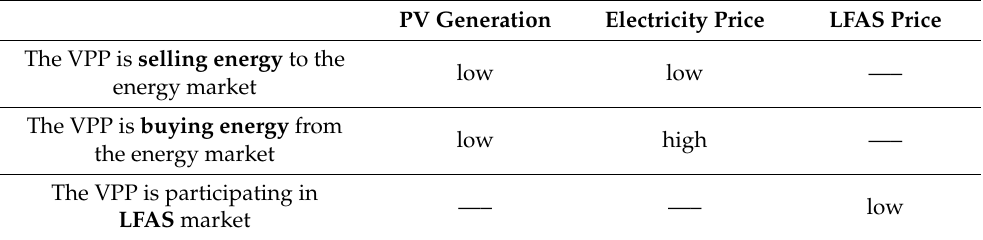
Table 1. The worst-case scenario for participation in LFAS and energy market. PV Generation Electricity Price LFAS Price low energy market